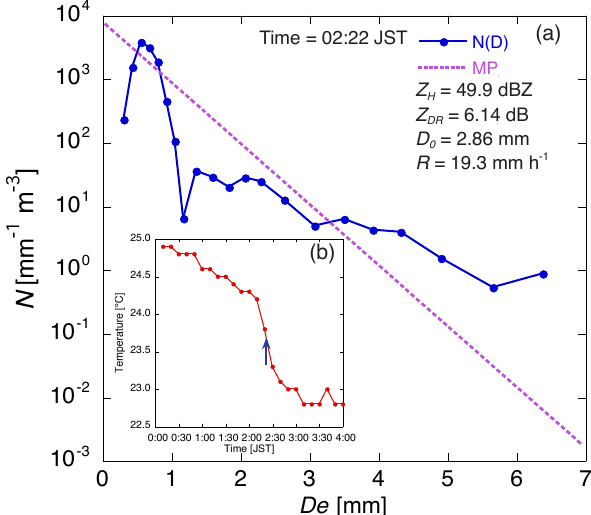
Fig. A3. Measurements at the Kumagaya station of (a) raindrop size distribution at 02:22JST averaged over 1min by a Parsivel disdrometer and (b) time series of surface temperature from 00:00 to 04:00JST on 7 July 2010. Lines with closed circles in (a) indicate the observed drop size distribution with the corresponding Z H , Z DR , D 0 , and rainfall rate on the upper right. The dashed line depicts an exponential Marshall–Palmer fit at a rainfall rate of 19.3mmh − 1 . The arrow in (b) indicates the time of DSD measure-